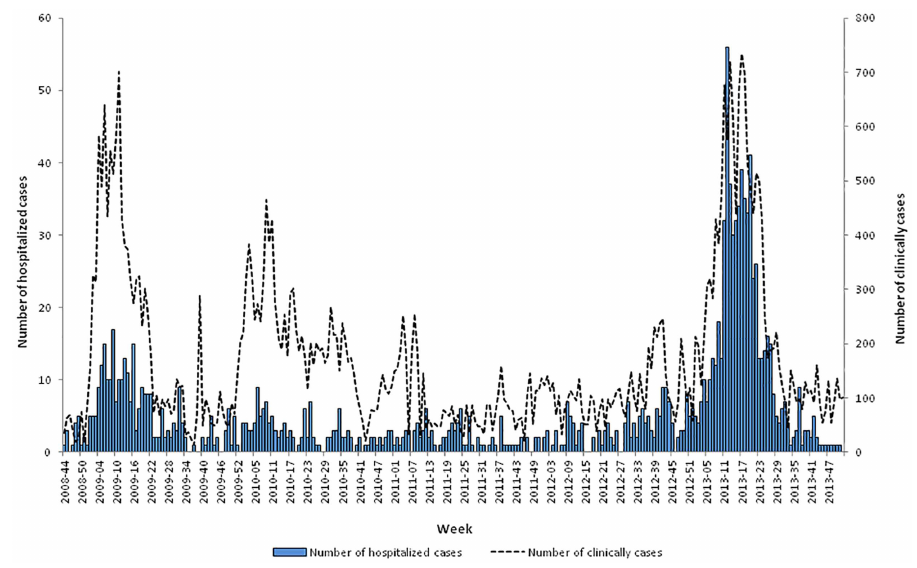
Fig 1. Weekly number of hospitalized dengue cases and the distribution of clinically estimated cases (n = 1356), French Guiana, 2008–2013.